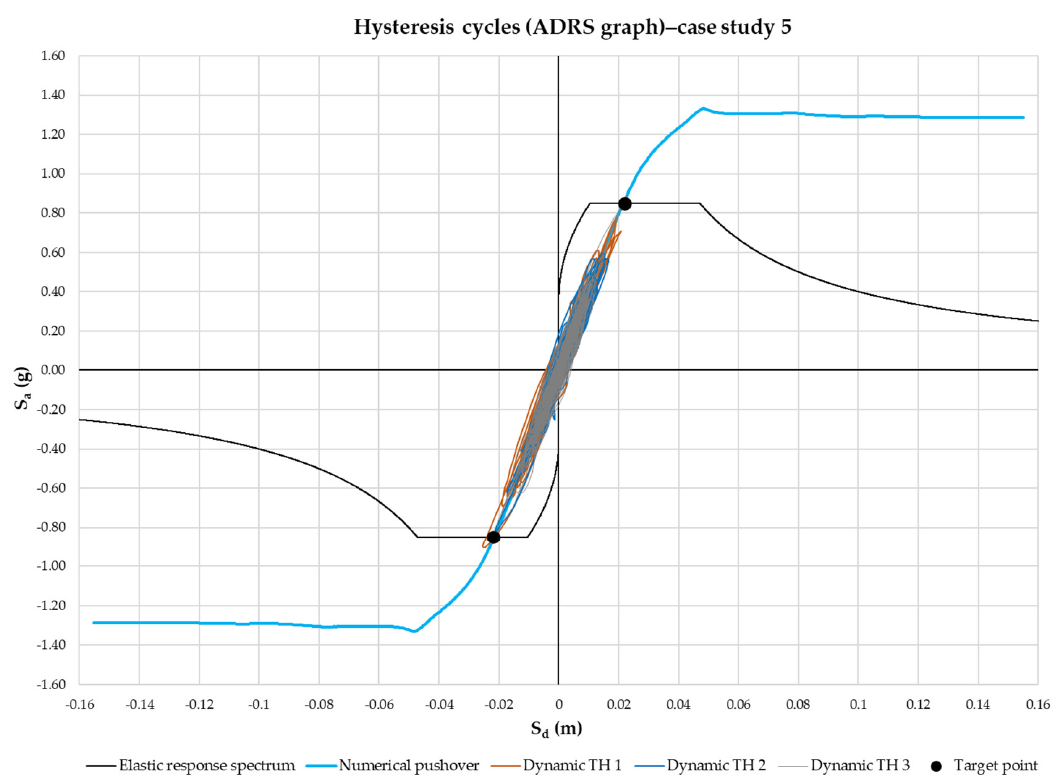
Figure 19. Hysteresis cycles obtained from the dynamic time-history analysis for case study 5.